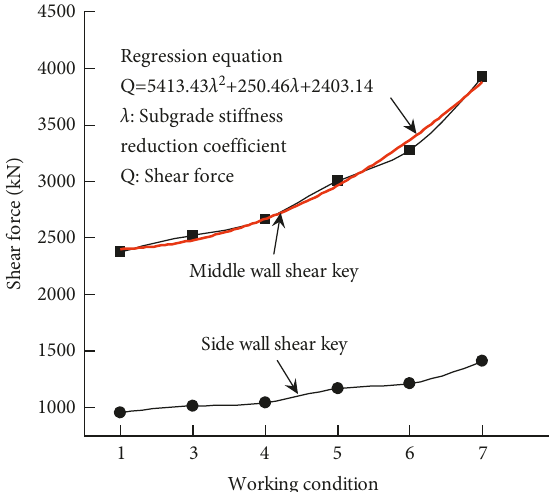
Figure 18: The shear force on joint 1 under different working conditions.